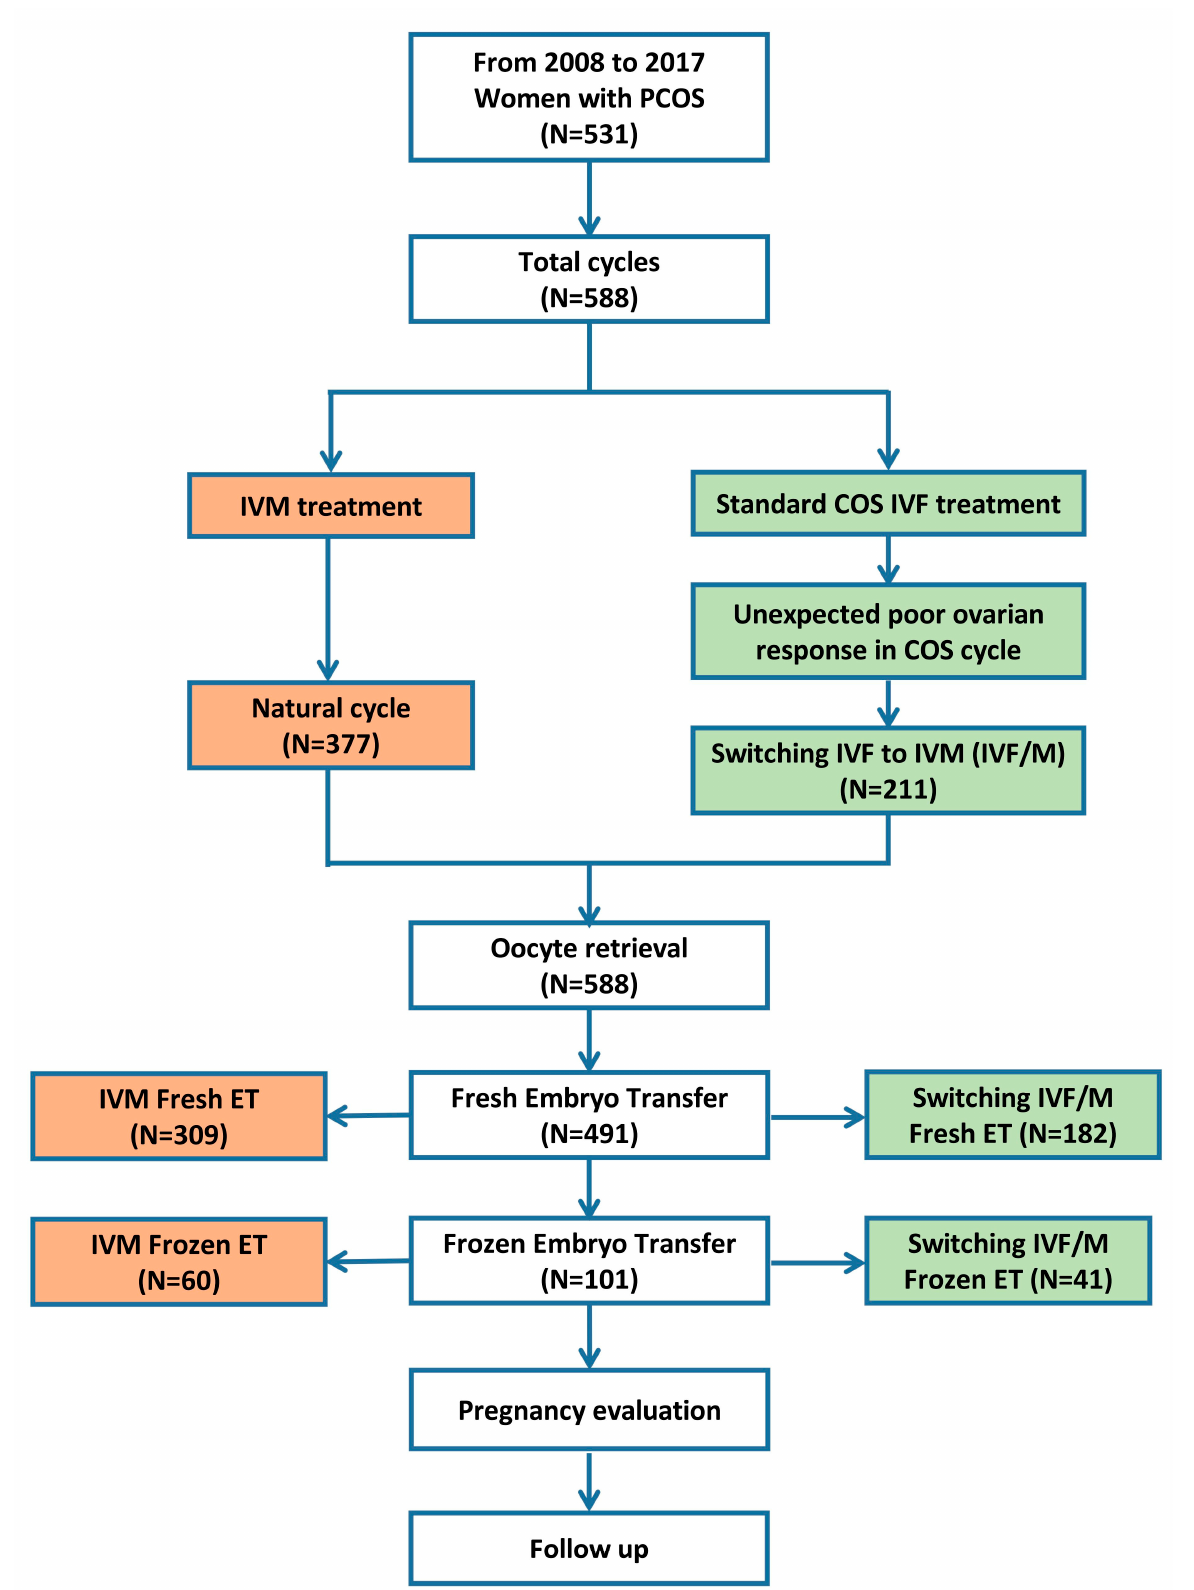
Figure 1. Flowchart of this retrospective cohort study. COS, controlled ovarian stimulation; IVF, in vitro fertilization; IVM, in vitro